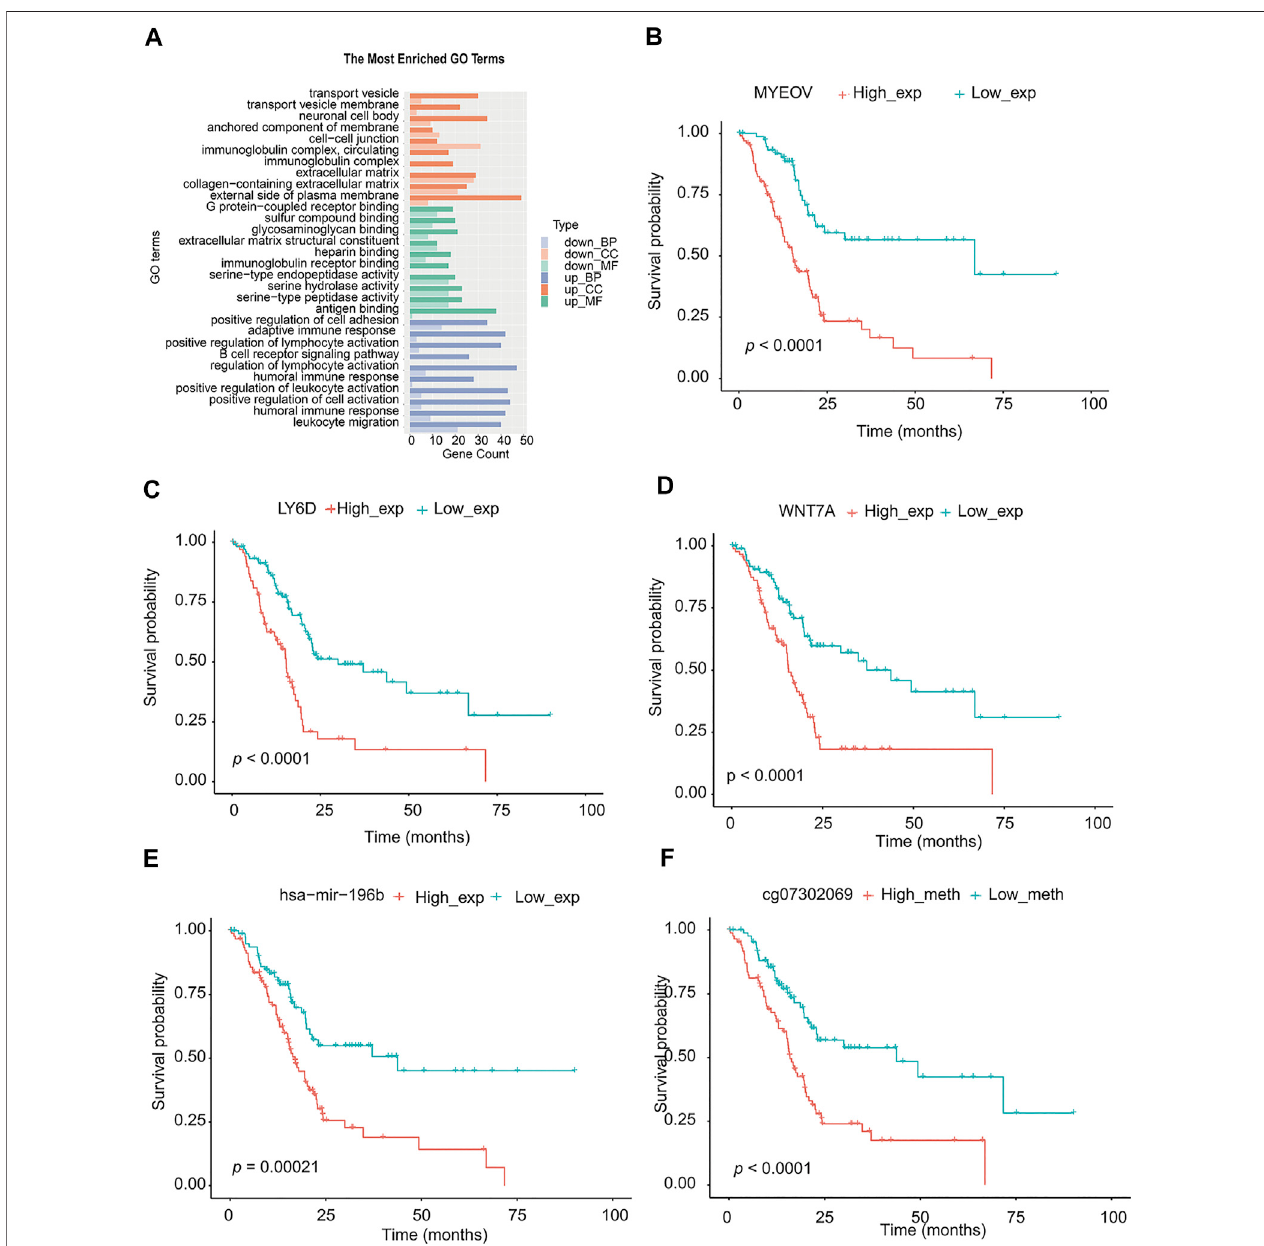
FIGURE 6 | Analysis of signal pathway, partial genes, and prognosis of DEGs in TMEscore-high and TMEscore-low group. (A) Enrichment of DEGs by GO. (B) Survival analysis of MYEOV gene. (C) Survival analysis of LY6D gene. (D) Survival analysis of WNT7A gene. (E) Survival analysis of hsa-mir-196b. (F) Survival analysis of the methylation site of